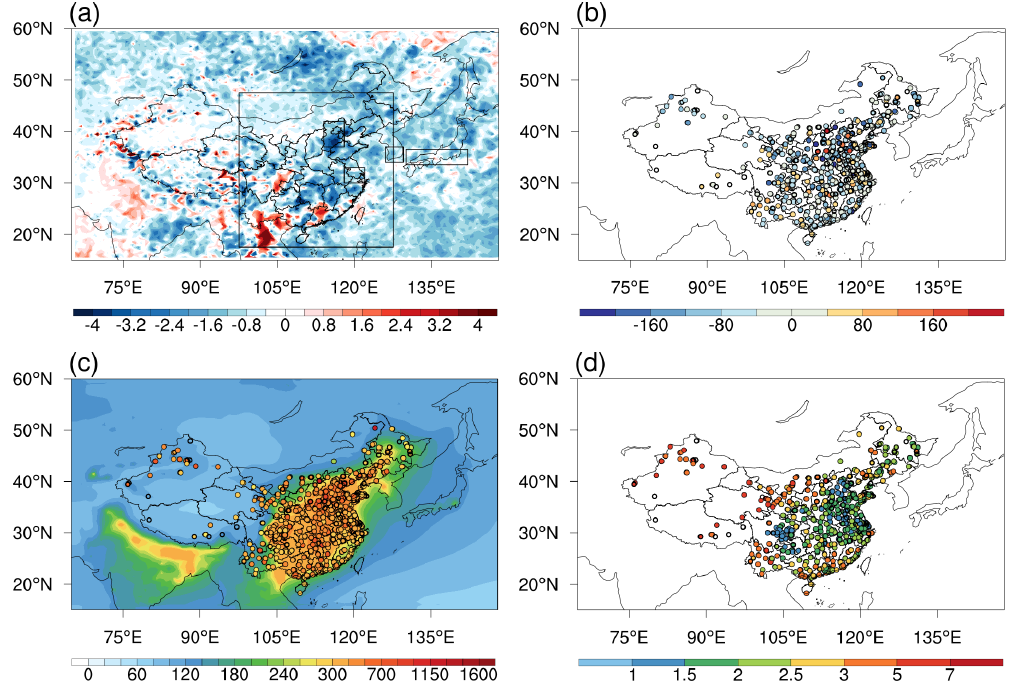
Figure 1. (a) Trends of MOPITT CO columns (Xco) in 2015–2020 with unit ppbyr − 1 ; (b) trends of MEE surface CO concentrations in 2015–2020 with unit ppbyr − 1 ; (c) modeled (contour, a priori simulation) and observed (dotted) surface CO concentrations in 2019 with unit ppb; (d) ratios between observed and modeled (a priori simulation) surface CO concentrations in 2019. The black boxes in panel (a) define the domains (land only) of East China, NCP, YRD, South Korea, and Japan. The areas outside of China are excluded in the East China